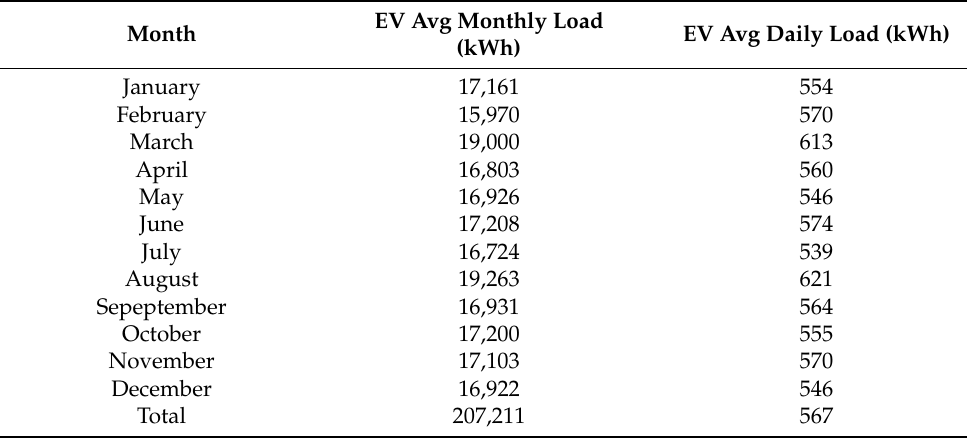
Table 5. Energy consumption of EV based on the generated load